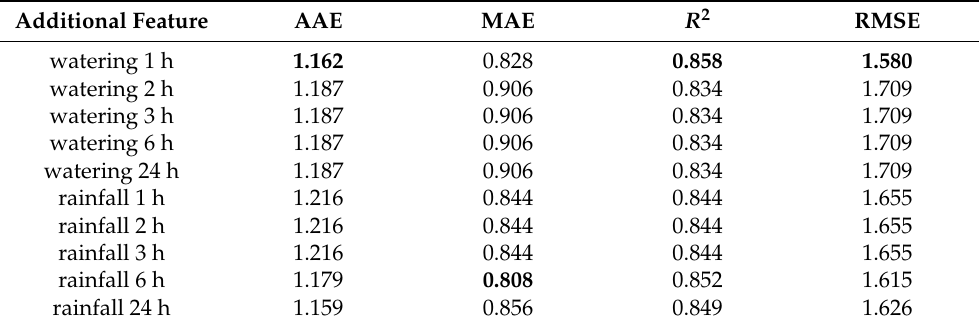
Figure 4. The comparison of the different models with additional information on watering and measured rainfall and with different time-frames when those features were analyzed. Compared results ( y -axis) were calculated for different models ( x -axis) with information on watering or measured rainfall during the past: 1, 2, 3, 6, or 24 h. Table 4. Results for Extra Trees models with additional features on watering or rainfall. Results presented in consecutive rows correspond to different watering or rainfall cumulating time-frames. The best results are in bold